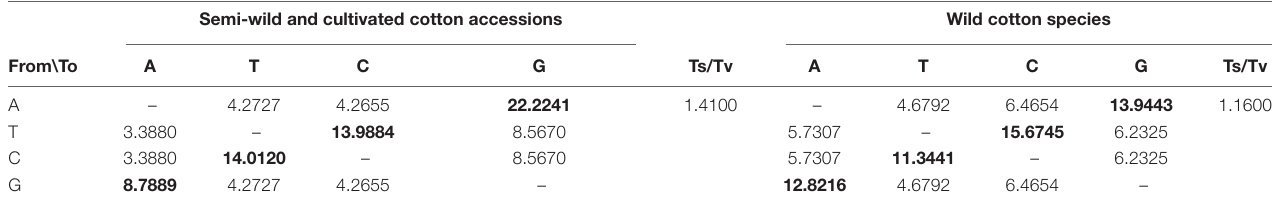
TABLE 2 | Ratios of transitions and transversions for plastid protein-coding sequences in cotton